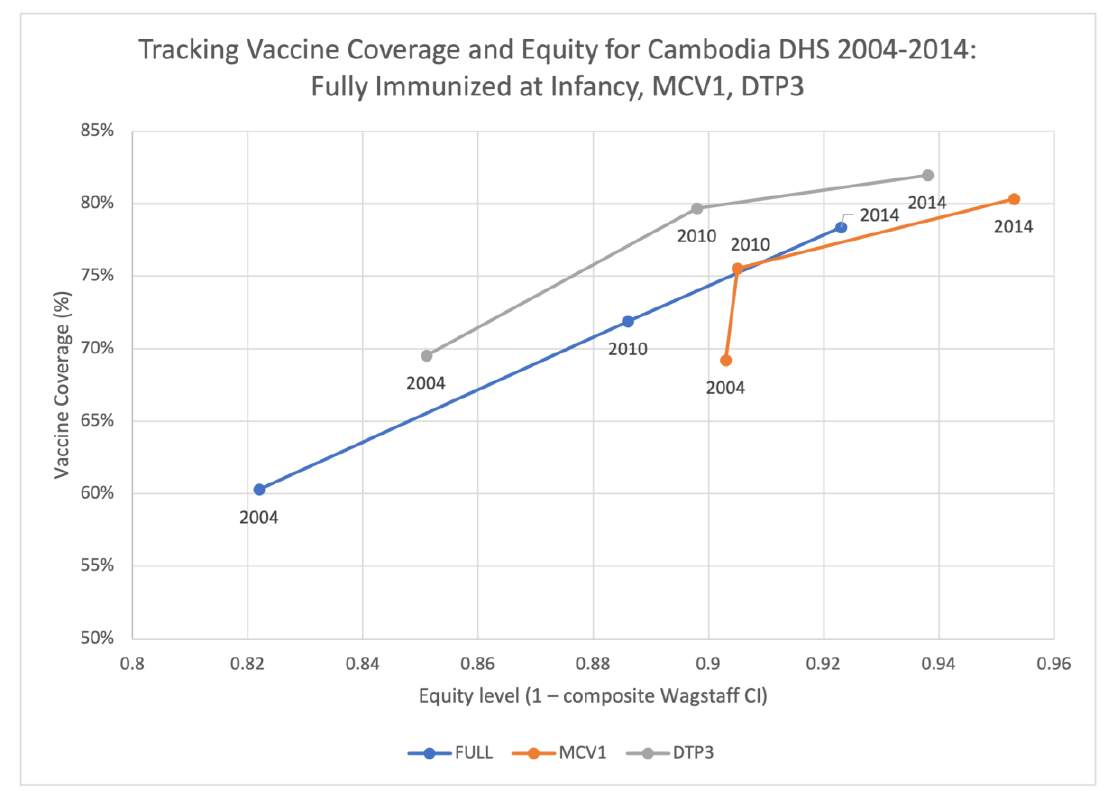
Figure 4. Tracking vaccine coverage and equity for Cambodia DHS 2004–2014: ZERO.